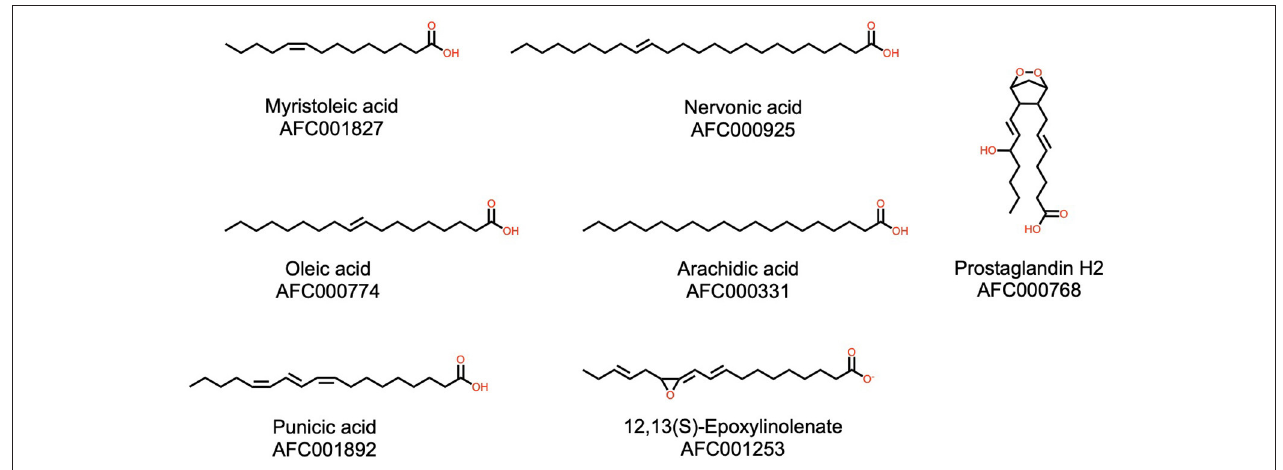
FIGURE 3 | Examples of terpenoids (including triterpenoids, sterols) present in the watermelon plant. Please see Materials and Methods (section AFC Identifiers) for the definition of the AFC identifiers.